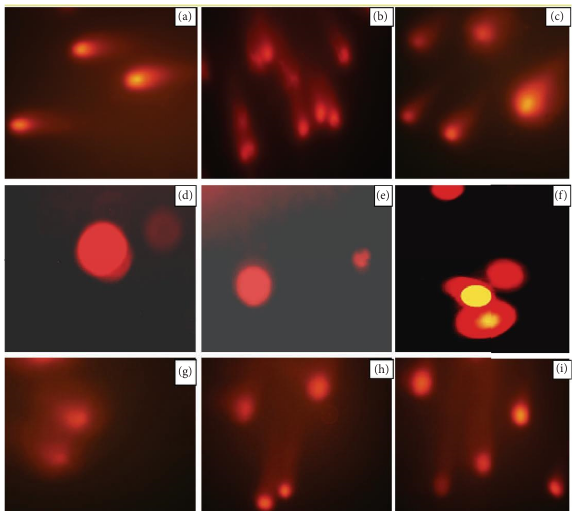
Figure 5: (a–c) represented DNA damage at 4h ( T 1 ), 8h ( T 2 ), and 16h ( T 3 ) of anesthesia induction in group A patients, respectively. (d) and (e) represented DNA damage at T 0 , (f) and (g) represented DNA damage at 4h ( T 1 ), (h) represented DNA damage at 8h ( T 2 ) and (i) represented DNA damage at 16h ( T 3 ) of induction of general anesthesia in group B patients,